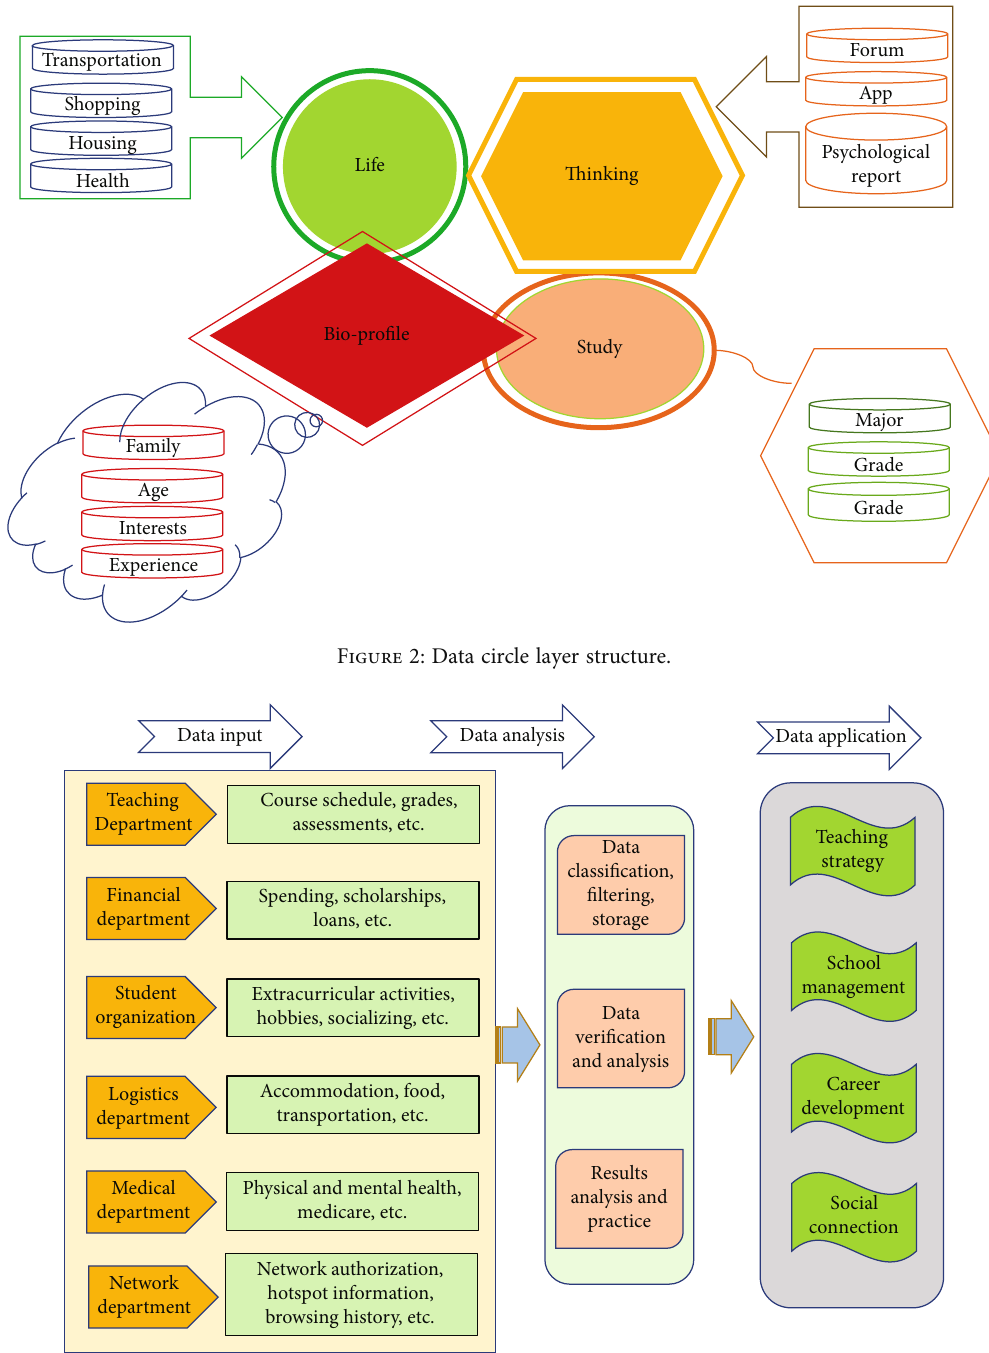
Figure 3: Data fl